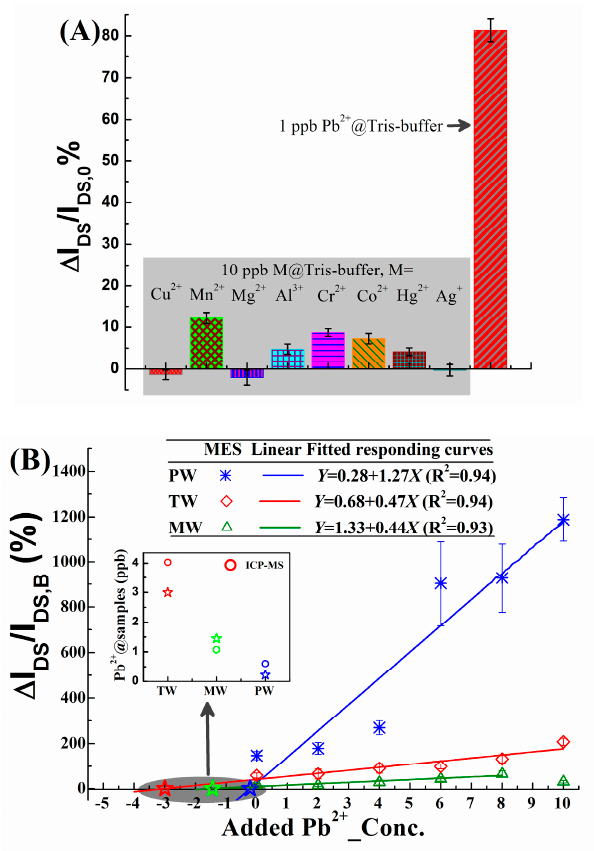
Figure 6. Application tests for the proposed rGO-COOH based GFET as an apta-sensor. ( A ) The specificity for Pb 2 + is verified by the examinations for un-target metal ions (M = Cu 2 + , Mn 2 + , Mg 2 + , Al 3 + , Cr 2 + , Co 2 + , Hg 2 + , Ag + ), respectively. ( B ) The measured I DS response for the added Pb 2 + standard samples in the tap water (TW) from municipal supply, as well as marketed mineral water (MW) and pure water (PW). Error bar is RSD and n = 5. The inset in (B) is the calculated Pb 2 + concentrations in three samples (Pb 2 + @samples), according to SAM (details are in Section 2.7); while the ICP-MS measured results for the same samples are plotted in the same coordinate to make a comparison.